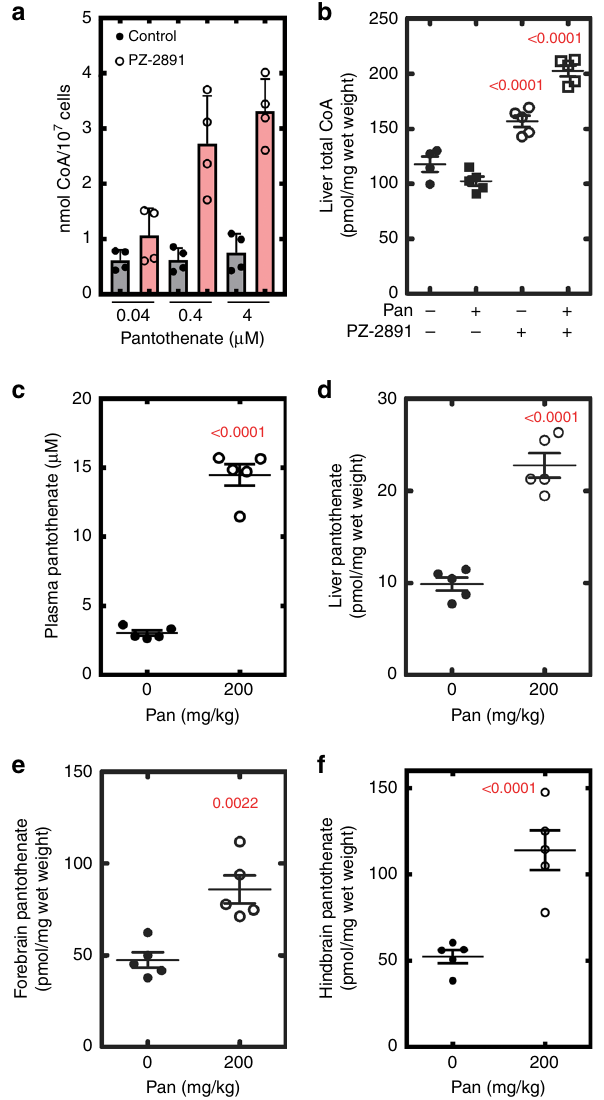
Fig. 5 Pantothenate concentration and PZ-2891 activation of CoA synthesis in animals. a Pantothenate-dependent PZ-2891 elevation of CoA in cultured C3A cells. Pantothenate levels were manipulated by supplementing pantothenate-free DMEM + dialyzed FBS. Control CoA levels (gray bars) are compared to cells treated with 10 μ M PZ-2891 (pink bars). Data are from two experiments performed in duplicate, and plotted as the mean ± SEM. b Groups of 5 mice were treated with fi ve doses of PZ-2891 (30 mg/ kg) without or with 200 mg/kg pantothenate. PZ-2891 was administered at 12 h intervals, and 4 h after the last dose the animals were euthanized and the CoA content of the tissues determined. Untreated mice ( fi lled circles); pantothenate-treated mice ( fi lled squares), PZ-2891 treatement (open circles), and PZ-2891 + pantothenate (open squares). c – f Groups of 5 animals were gavaged with 200 mg/kg of pantothenate using the same regimen as in b , and four hours after the last dose, tissues were harvested and the pantothenate concentrations measured by mass spectrometry. c Plasma. d Liver. e Forebrain. f Hindbrain. Mean± SEM are plotted, and the p values are in red. Control pantothenate levels ( fi lled circles), pantothenate levels in pantothenate-treated mice (open